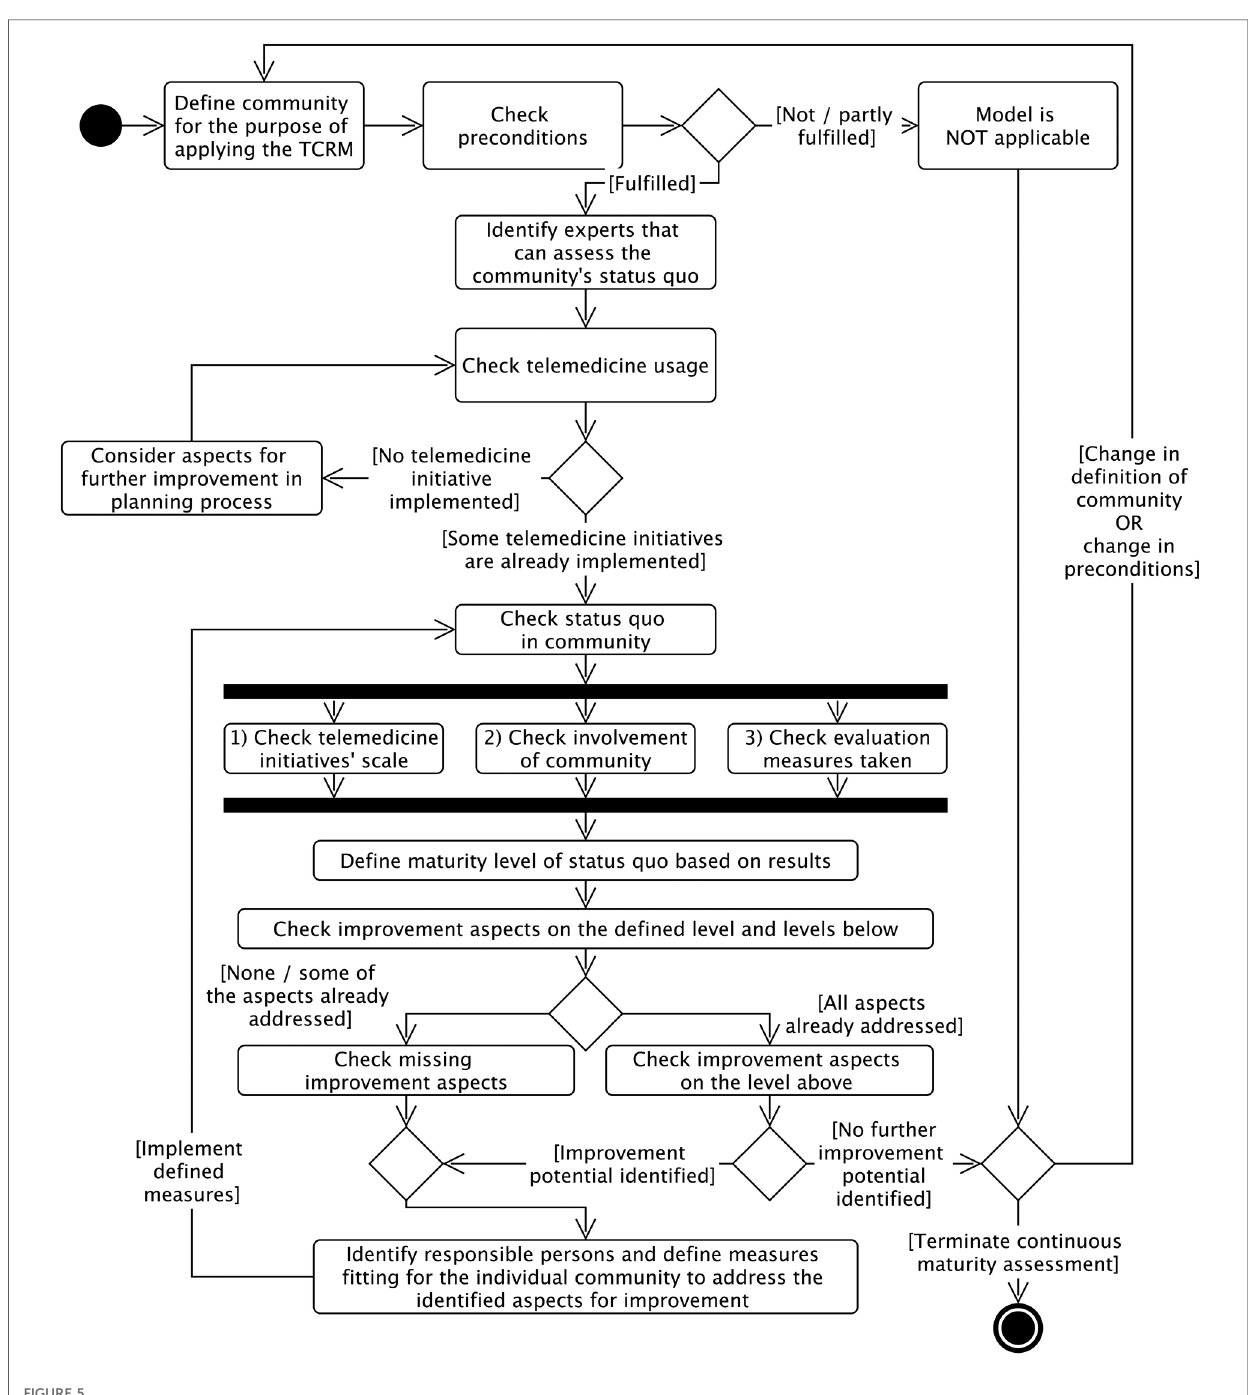
FIGURE 5 Procedure model of the